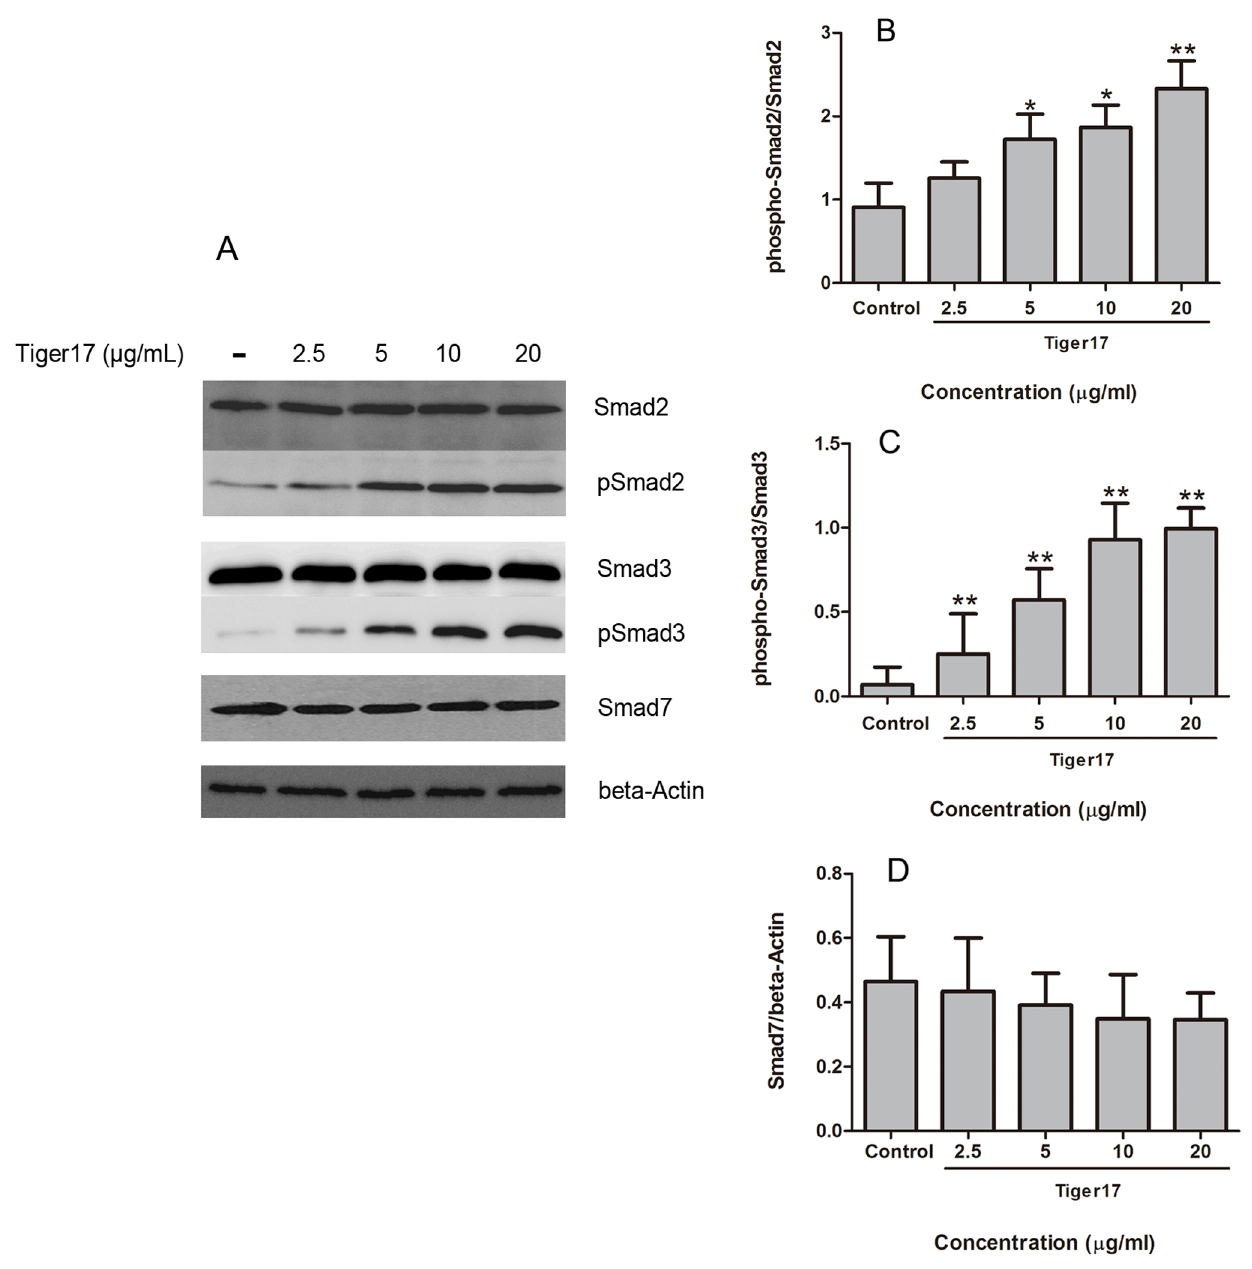
Figure 4. Effects of tiger17 on the Smads signal pathway. (A) Raw 264.7 cells were treated with the indicated concentrations of tiger17 (2.5, 5, 10, 20 m g/ml) or vehicle; Western blotted for total-Smad2, p-Smad2, total-Smad3, p-Smad3 or toal-Smad7 was performed. b -Actin was used as the internal control. (B, C, D) The band intensity of various inducer of Smads pathway=each phosphate-contents/homologous total-contents. The band intensity of inhibitory Smad7=each Smad7-contents/the same concentration tiger17-stimulated b -Actin. (NIH, Image J). Values are the mean 6 SE of three independent experiments, *P , 0.05, **P , 0.01. doi:10.1371/journal.pone.0092082.g004 TGF- b 1 expression and fibroblasts to myofibroblasts differentia- tion as mentioned above.